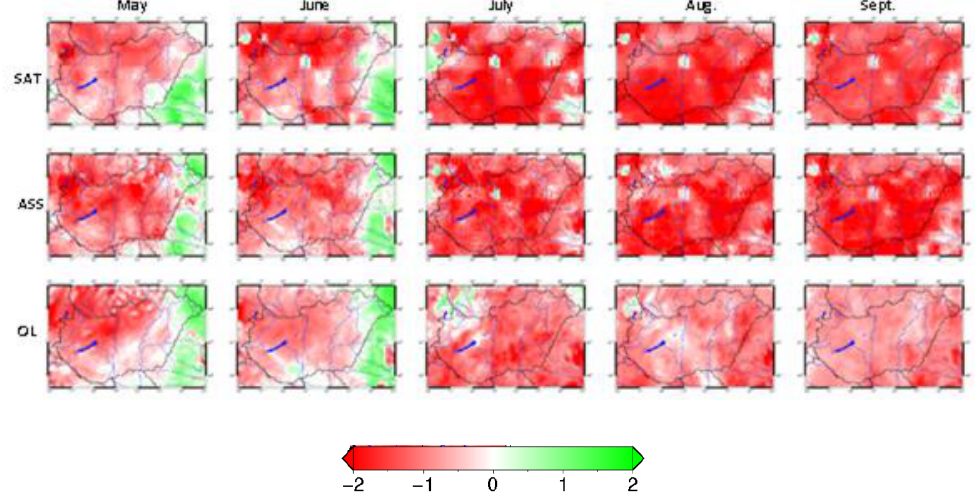
Figure 8. Monthly anomalies for the year 2012 from May to September: ASCAT/SWI-10 product (first row) assimilated WG2 (second row) and open-loop WG2 (third row).